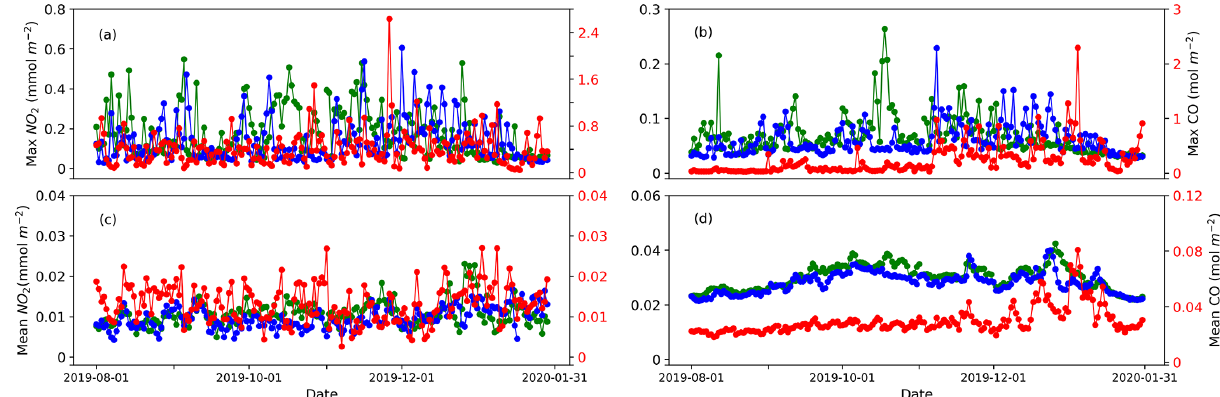
Figure 5. Time series of daily maximum NO 2 (a) and CO (b) total column densities from August 2019 through January 2020 as well as daily mean NO 2 (c) and CO (d) for three highlighted areas: Area 1 (green), Area 2 (blue), and Area 3 (red). Results for Areas 1 and 2 are displayed by the left Y axis, and results for Area 3 are displayed in red on the right Y